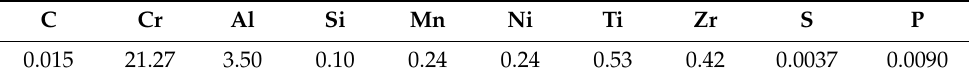
Table 1. Chemical composition of studied alloy (wt